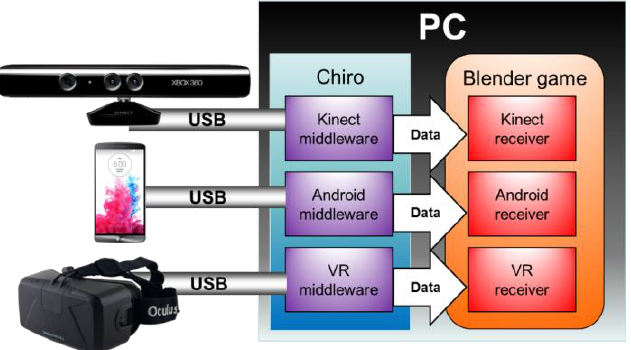
Figure 1. Block diagram of the modular container “Chiro” communicating different peripherals with Blender.